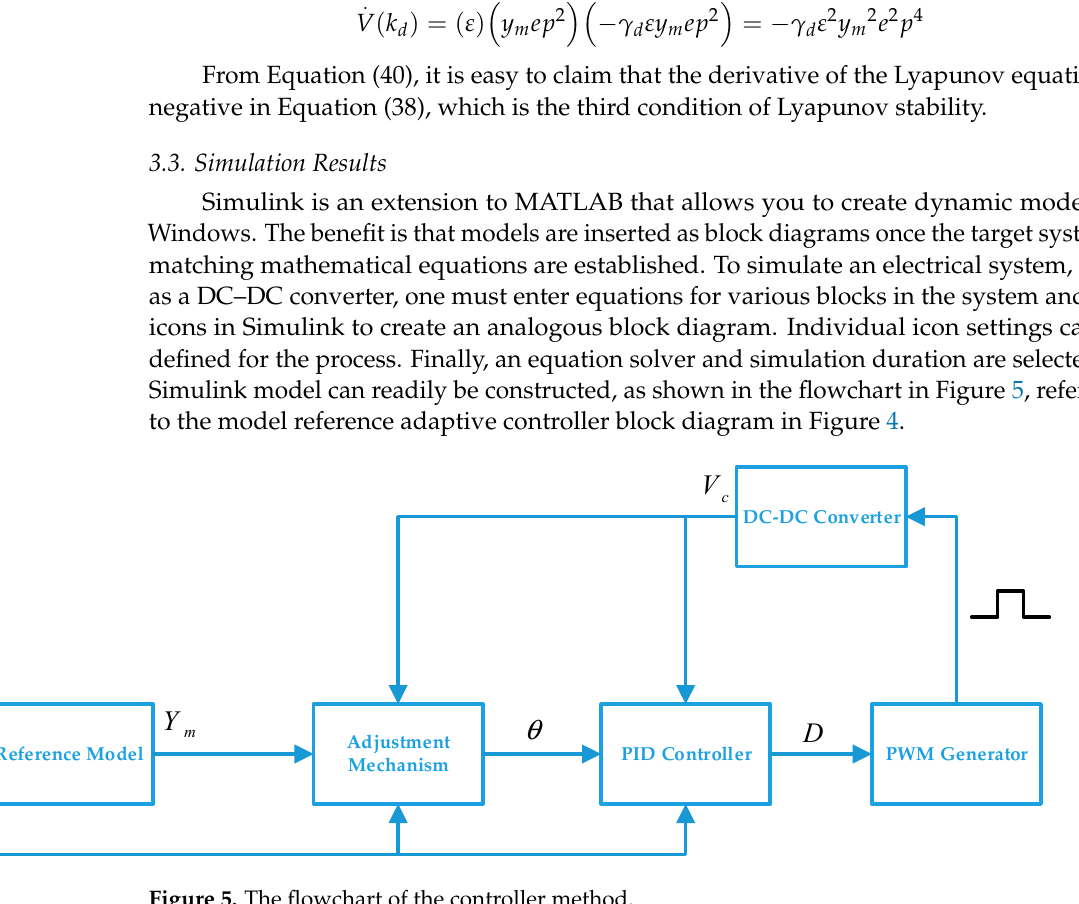
Figure 5. The flowchart of the controller method .